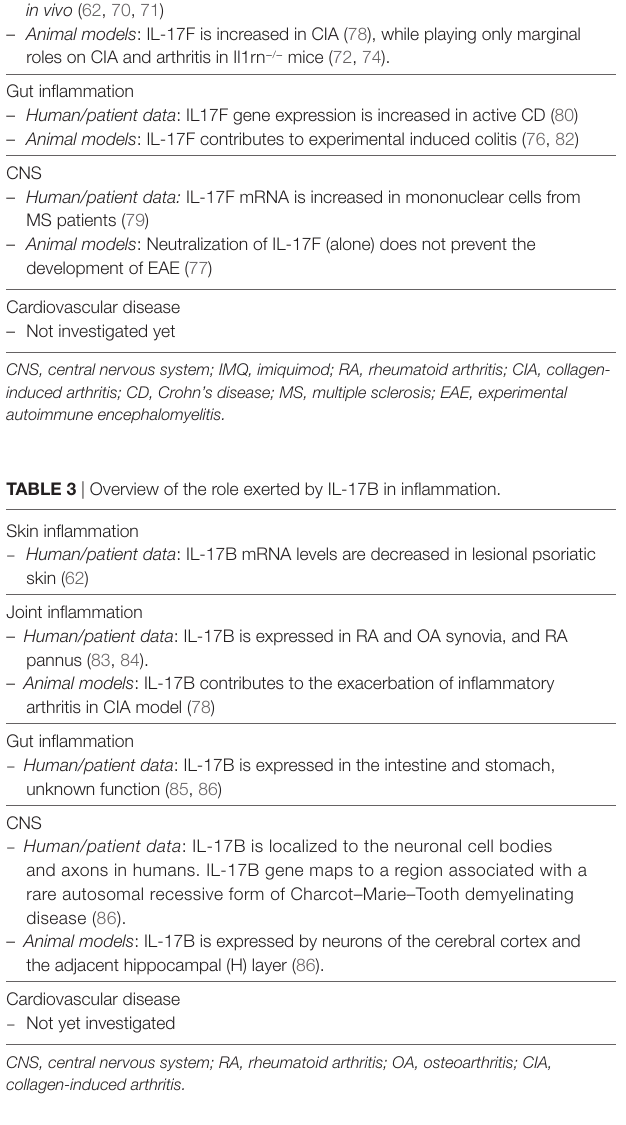
TABLe 2 | Overview of the role exerted by IL-17F in inflammation. Skin inflammation – Human/patient data : IL-17F is increased in psoriatic lesional skin. Elevated levels of IL-17F are found in sera from psoriatic and atopic dermatitis patients (62, 63, 65). – Animal models : IL-17F contributes to skin inflammation induced by IMQ application (66, 67). Joint inflammation – Human/patient data : IL-17F is expressed in the synovial tissue from RA patients and contributes to human chronic joint inflammation in vitro and in vivo (62, 70,